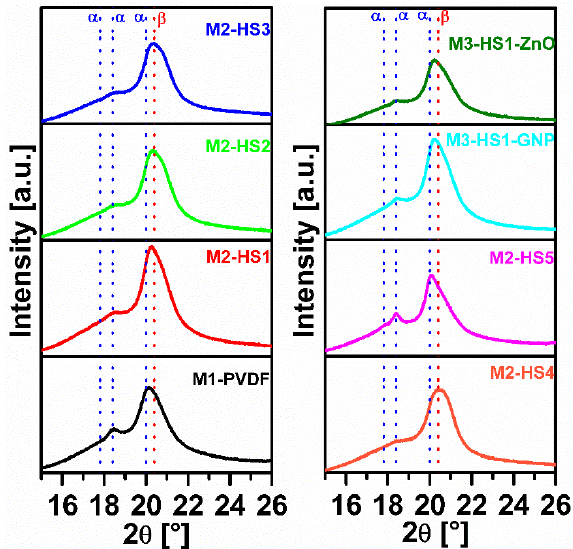
Figure 6. X-ray powder diffraction (XRPD) patterns acquired on the produced samples of PVDF nanocomposites.